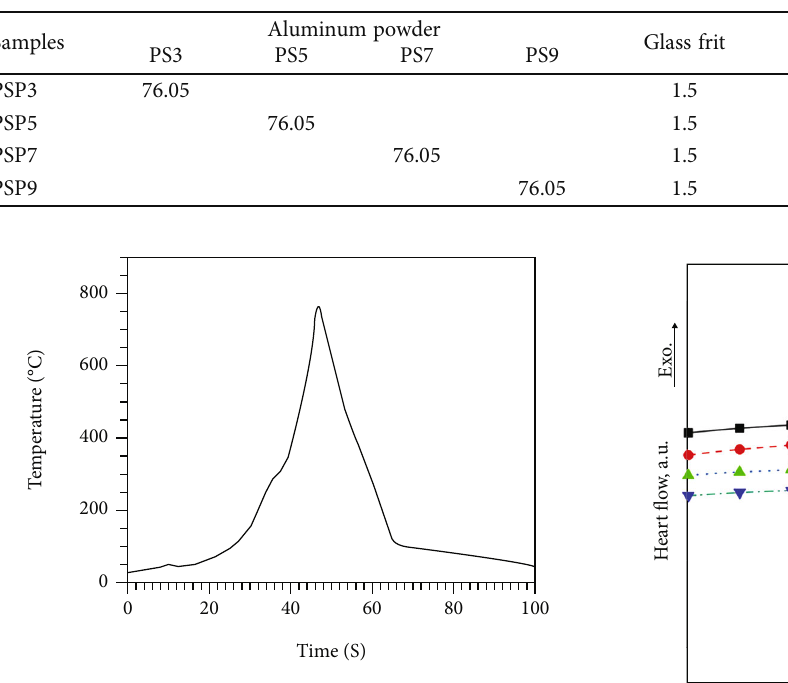
Table 2: Aluminum paste